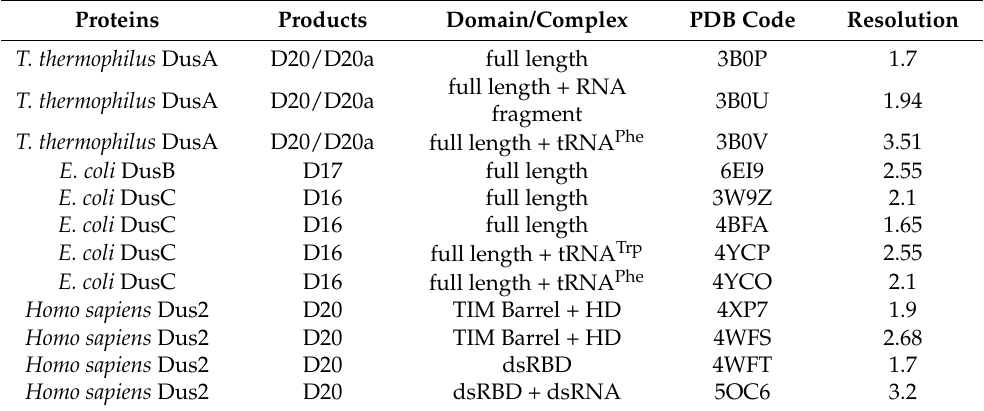
Table 1. X-ray structures of Dus available in the protein data